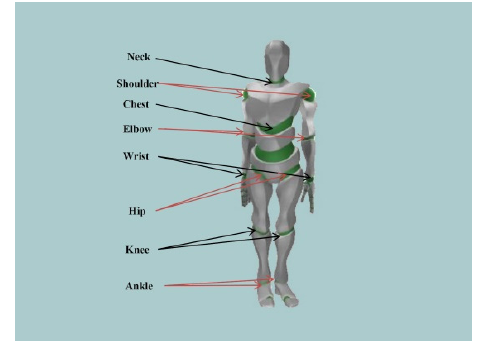
Figure 3. Representation of experiments.